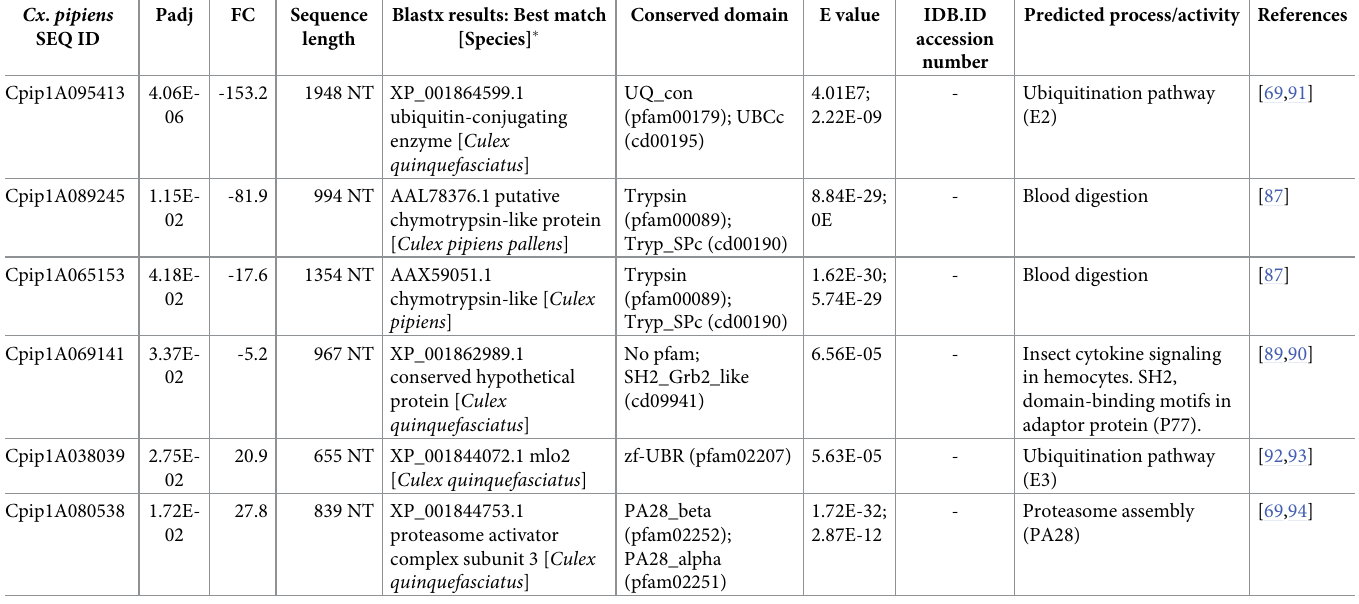
Table 3. DEG related to the immune infection-defense response at 3